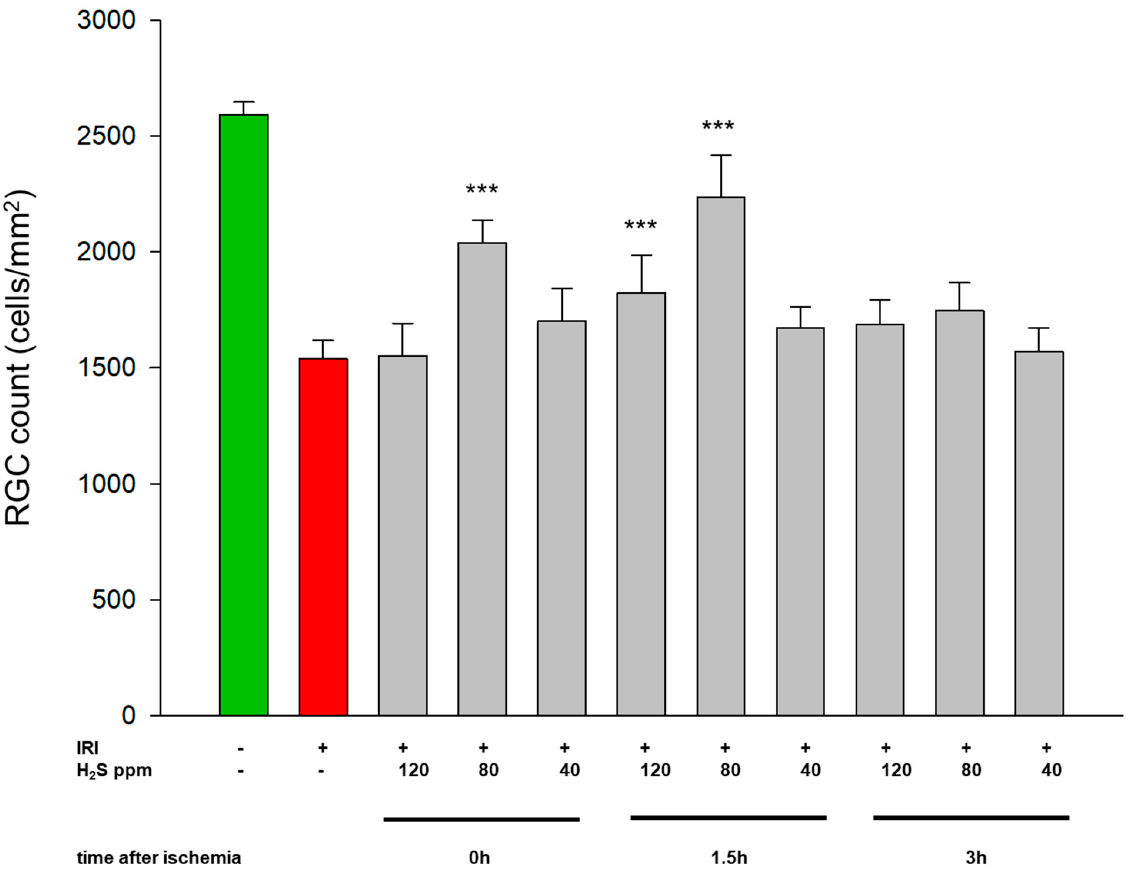
Figure 1. Time- and dose-dependent influence of H 2 S inhalation on retinal ganglion cell count after ischemia–reperfusion injury (IRI). Quantification of retinal ganglion cell density (cells/mm 2 , data are the mean ± SD, n = 8, *** = p < 0.001; IRI vs. IRI + 80 ppm H 2 S at 0 h and 1.5 h, vs. IRI + 120 ppm H 2 S at 1.5 h) .